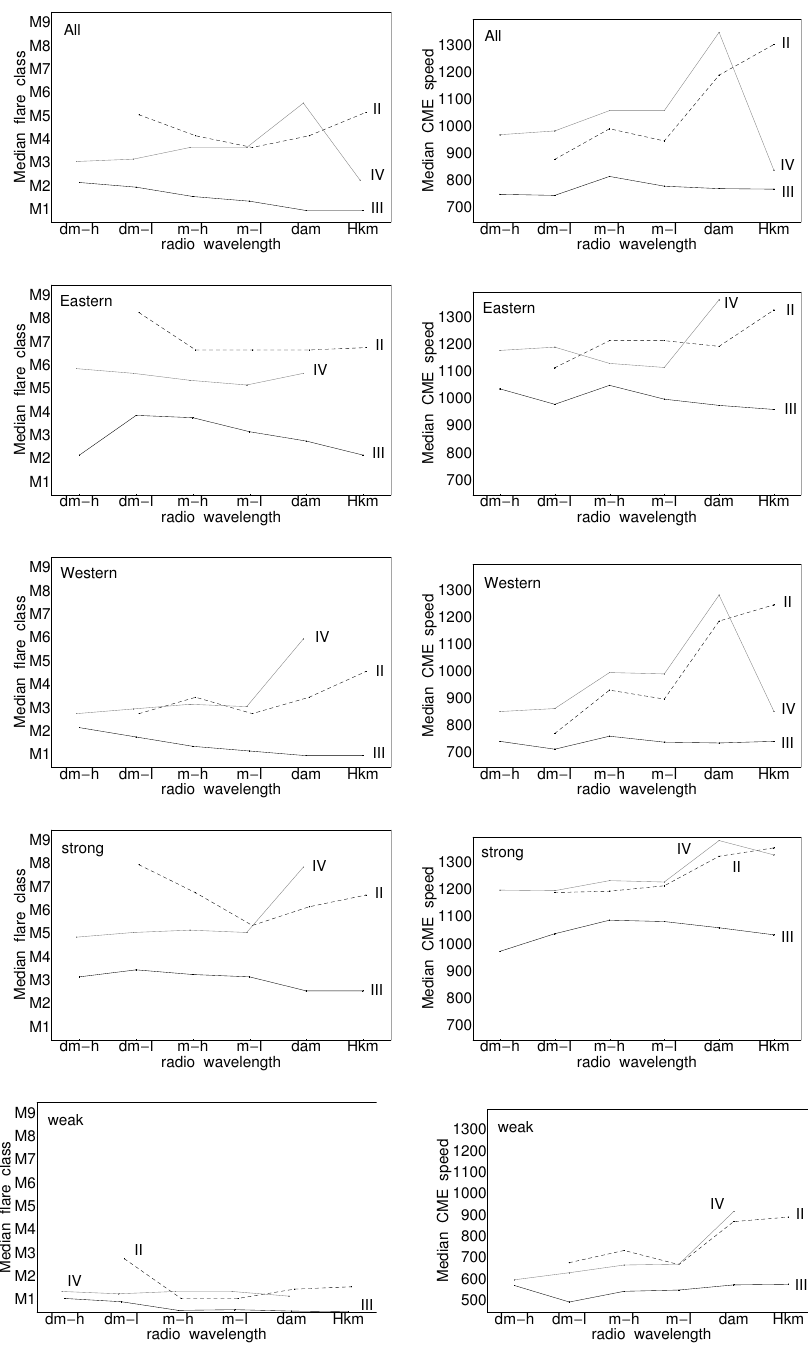
Figure 5. Plots of the wavelength dependency of the SF class (on the left ) and CME speed (on the right ) in median values. The sample type (All, Eastern, Western, strong or weak) and burst type (II, III and IV) are denoted in each